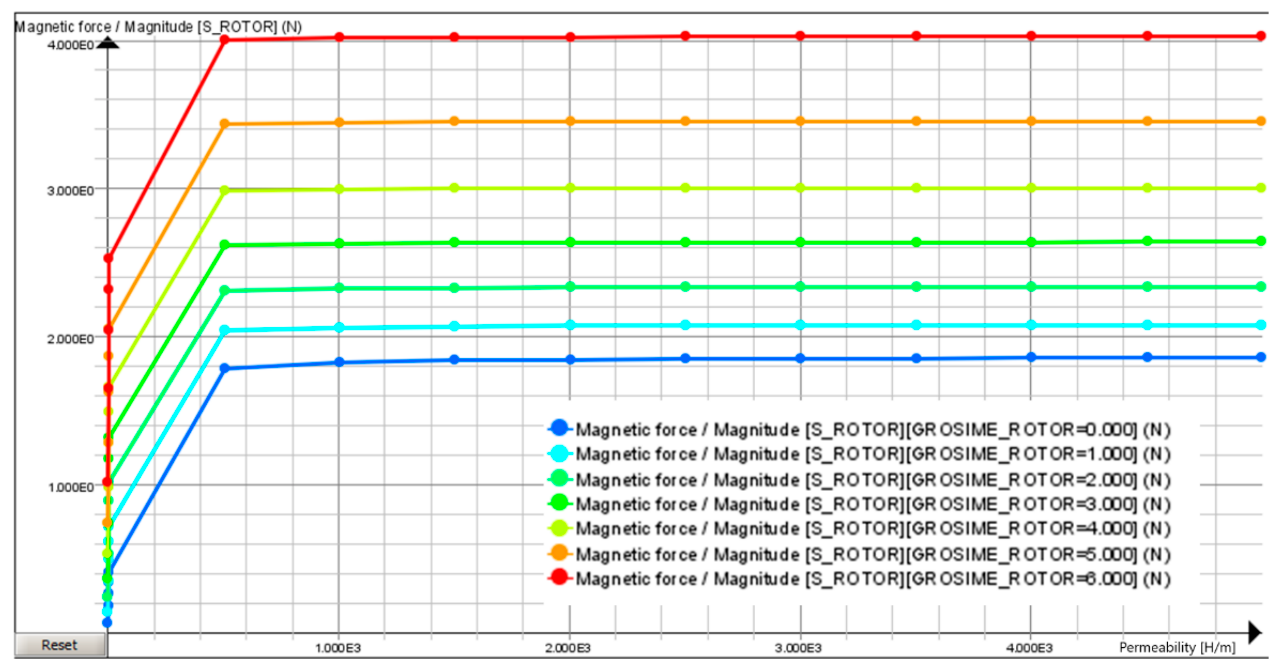
Figure 22. Variation of the magnetic force of attraction to the change in permeability gadolinium and rotor thickness (=GROSIME)—2D representation.